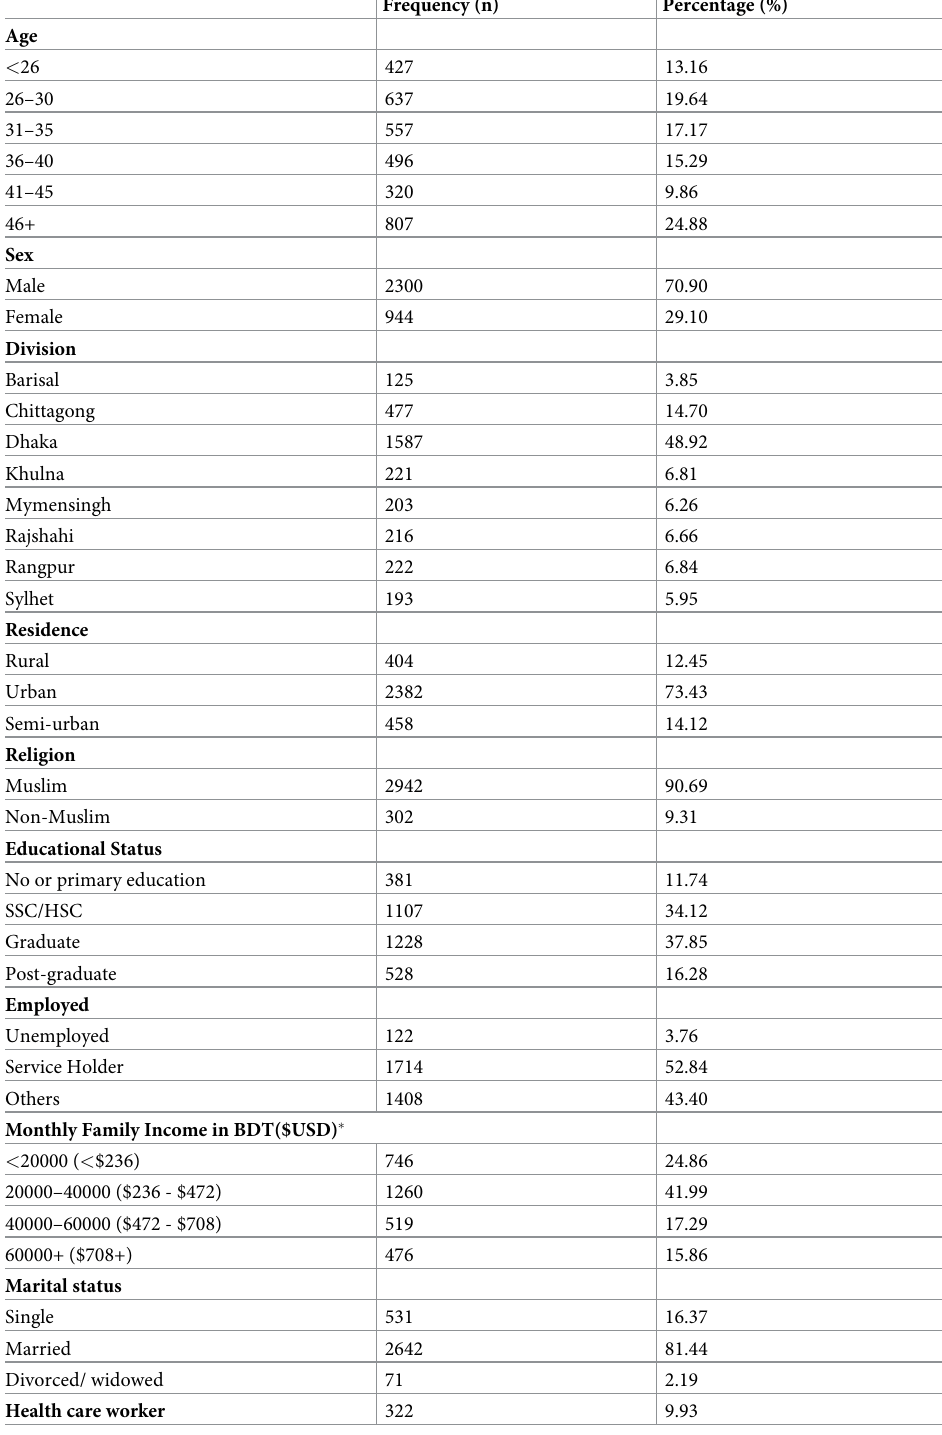
Table 1. Socio-demographic profile of the study